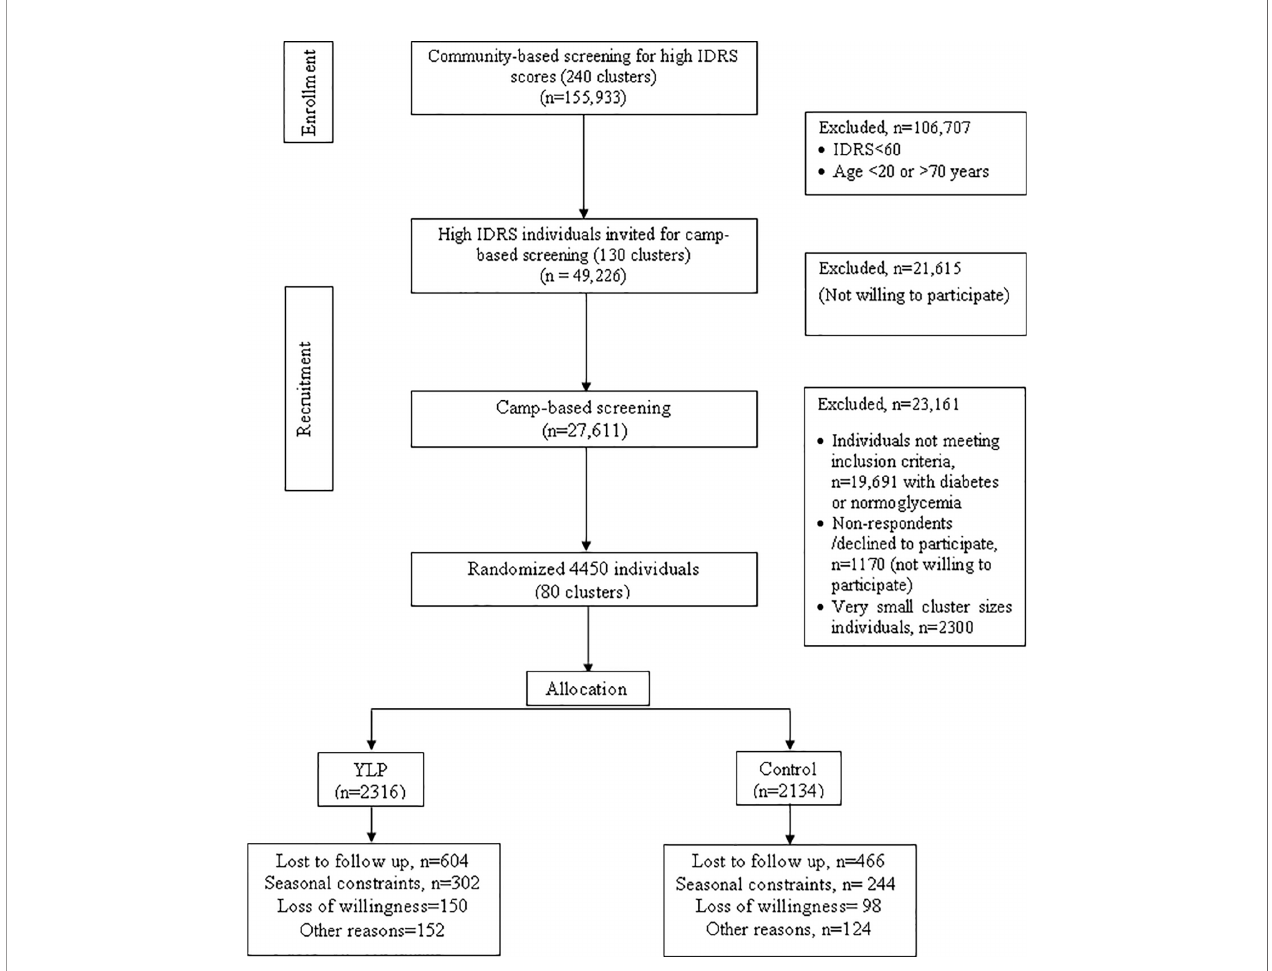
FIGURE 1 | NMB trial pro fi